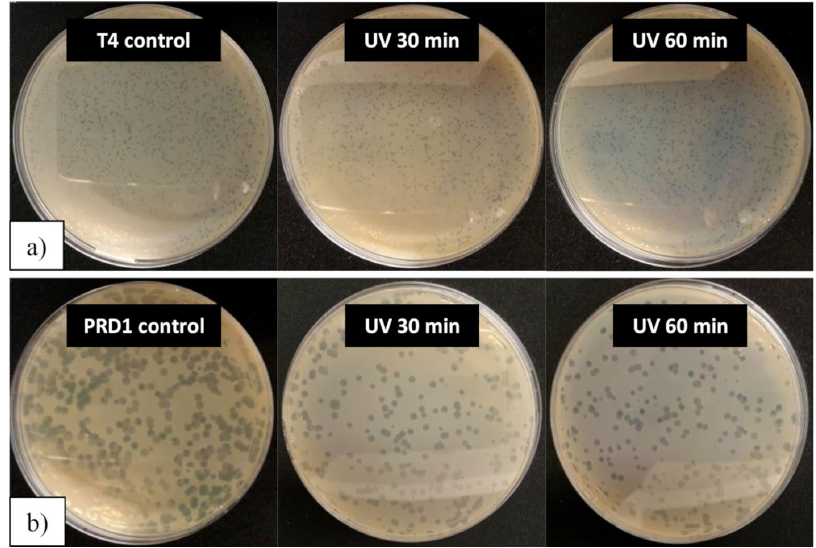
Fig. 5. Formation of plaques by treated bacteriophages T4: a) and PRD1 b). Photocatalytic treatment was performed using visible light and carbon doped TiO 2 thin